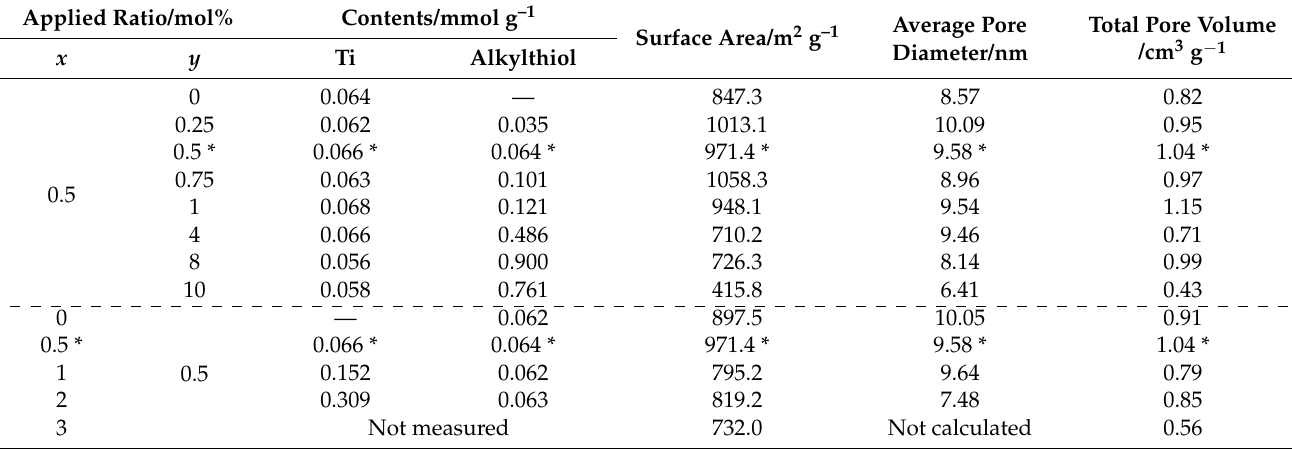
Table 1. The contents of functionalities and the physicochemical properties on Ti( x )-SBA SH ( y ).